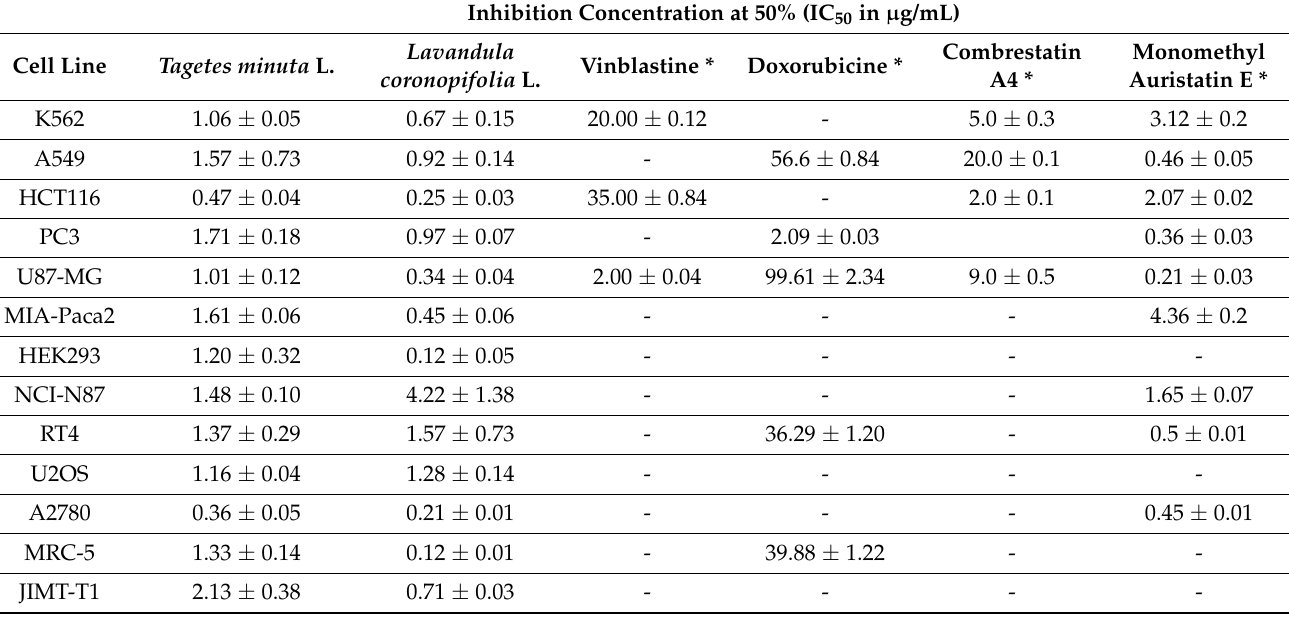
Table 7. IC 50 values for essential oils of Tagetes minuta L. and Lavandula coronopifolia